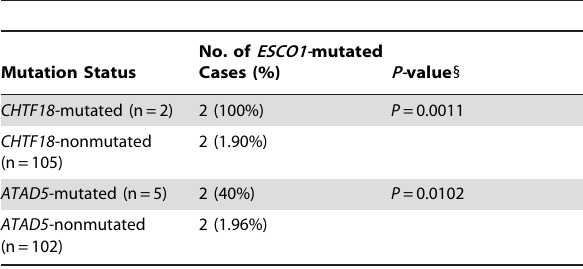
Table 3. Co-occurrence of ESCO1 mutations with CHTF18 or ATAD5 mutations in EC.